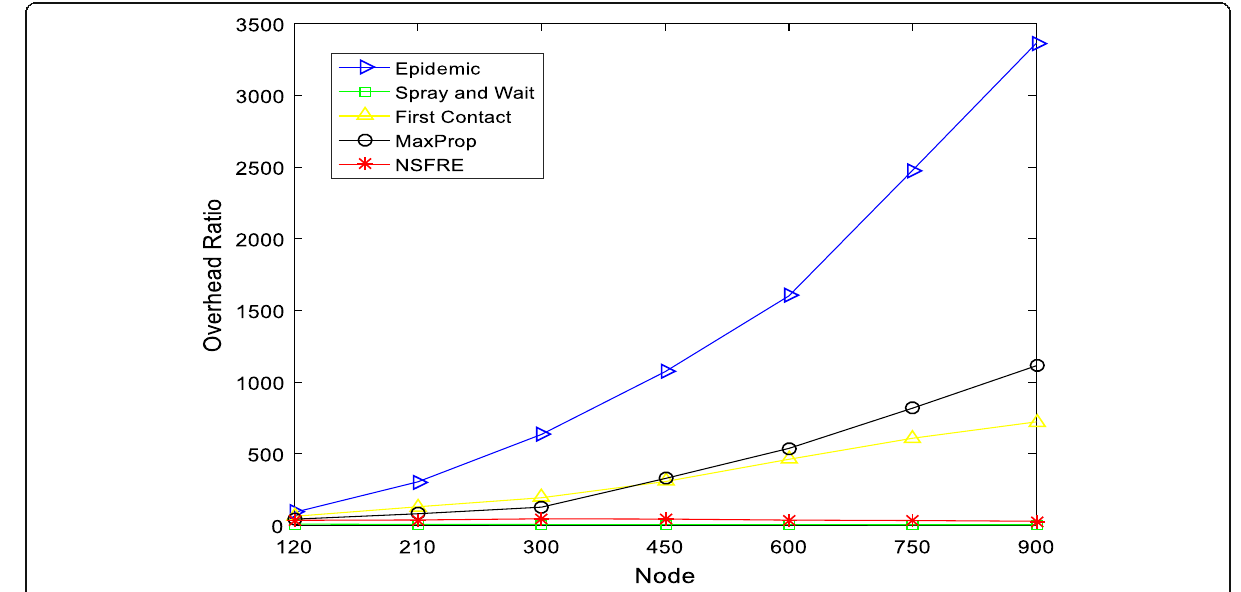
Fig. 8 The routing overhead and the number of